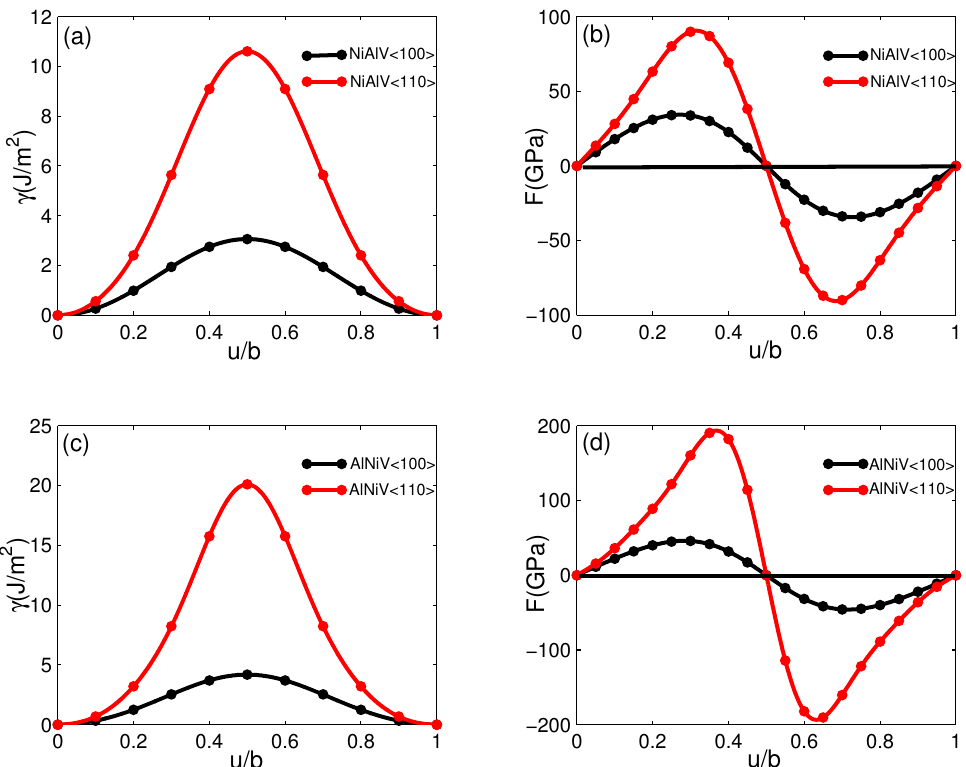
Figure 5. The generalized stacking fault energy curves and the corresponding restoring forces for the NiAlV interface AlNiV interface slip along (cid:104) 100 (cid:105) and (cid:104) 110 (cid:105) ,